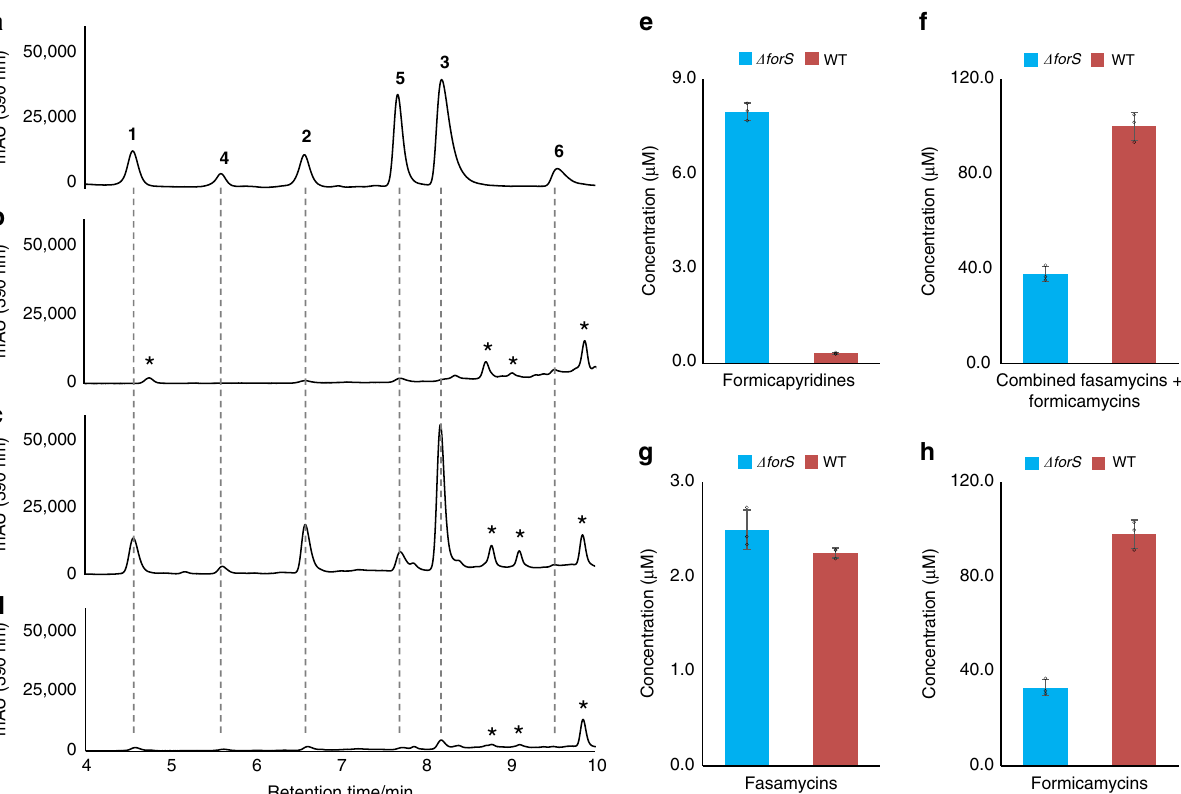
Fig. 6 Mutational analysis of forS . Reconstituted HPLC chromatograms (UV; 390 nm) showing: a formicapyridine standards 1 – 6 ; b S. formicae WT extract; c S. formicae Δ forS extract; d S. formicae Δ forS/forS extract. Quantitative data for the combined titre of each metabolite family produced by the S. formicae WT and Δ forS mutants are shown for: e total formicapyridines; f combined total fasamycins and formicamycins; g total fasamycins; h total formicamycins; (mean ± standard deviation; n = 3 (biological replicates)). The molecular species giving rise to peaks labelled with an asterisk are unrelated to the for pathway based on UV and m/z analysis. The source data underlying Fig. 6e – h are provided as a Source Data fi